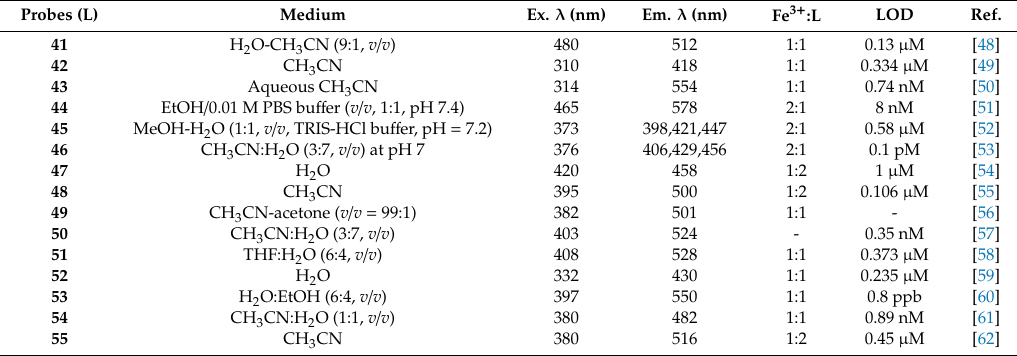
Table 2. Physiochemical properties of some iron(III) selective turn-on probes. Probes